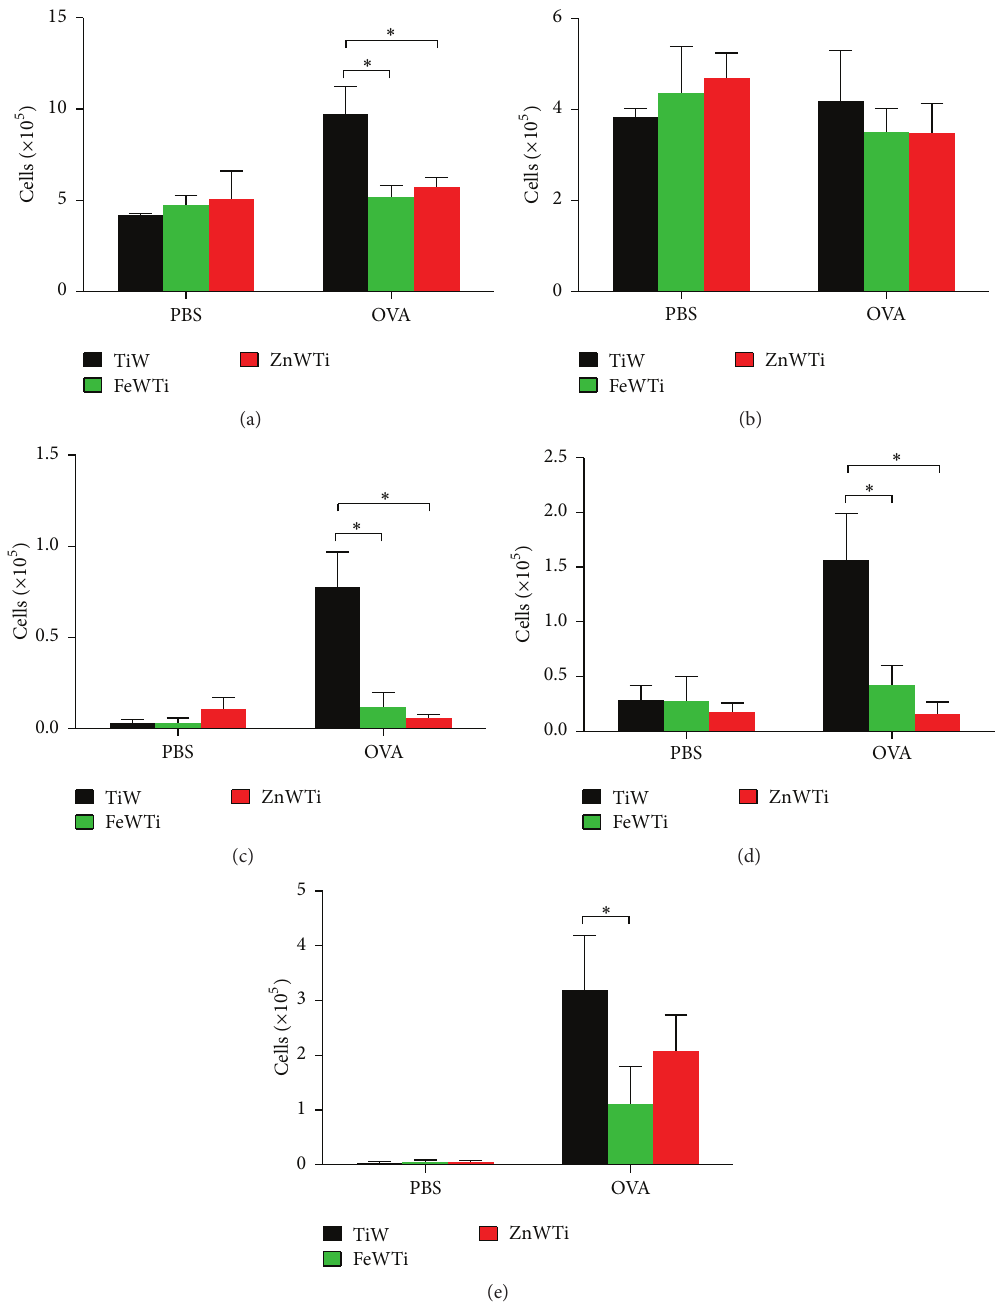
Figure 2: Polyoxometalates FeWTi and ZnWTi reduce inflammatory cells infiltration in the airway. Cells in the BALF were stained and counted; numbers of (a) total cells, (b) macrophages, (c) neutrophils, (d) lymphocytes, and (e) eosinophils; bars = SEM; 𝑛 = 7 mice/group/experiment; ∗ 𝑝 < 0.05 compared to mouse treated with TiW. Data are representative of 3 experiments.